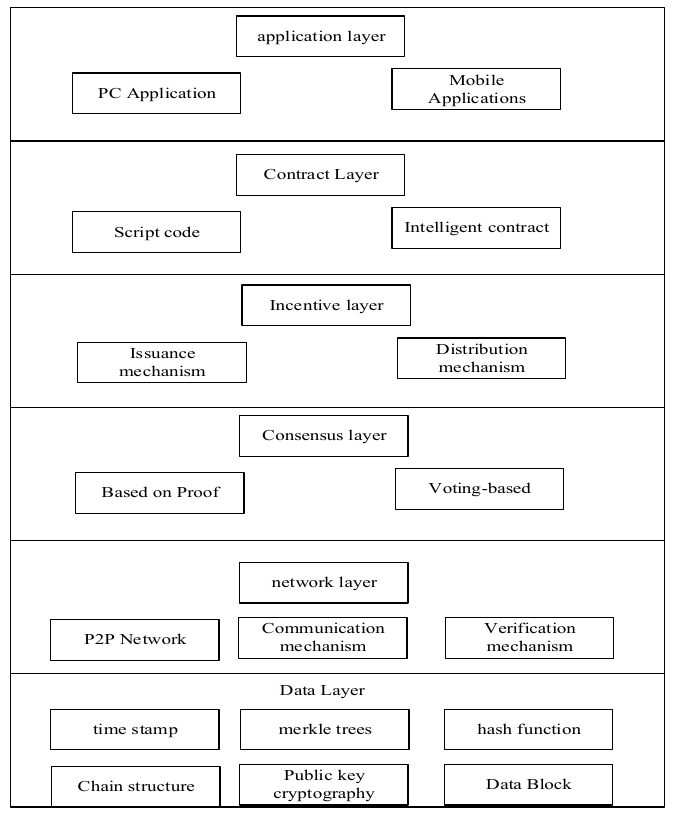
Figure 5. Blockchain framework.